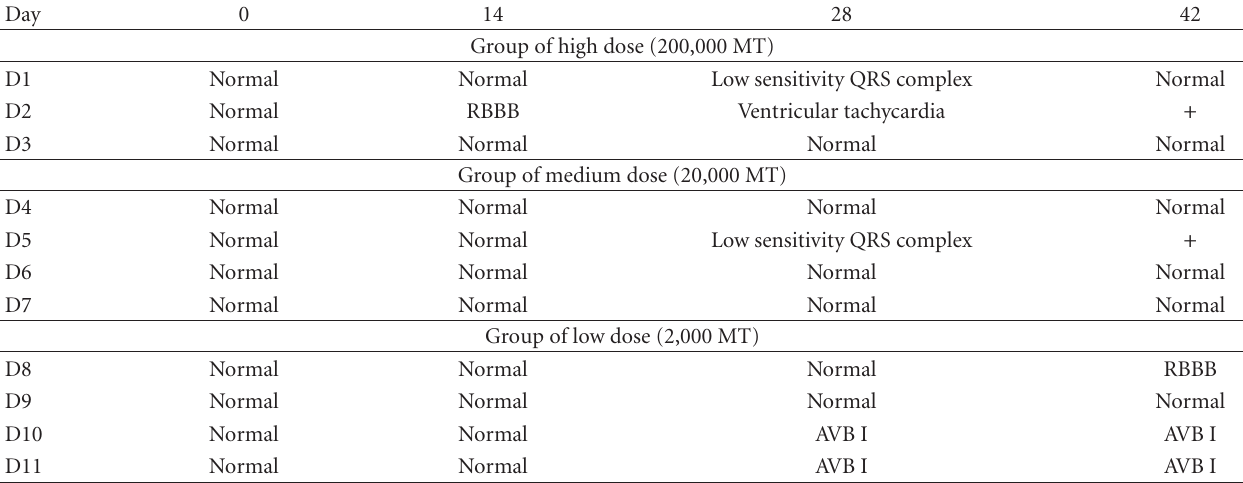
Table 1: Electrocardiography follow-up during evaluation period.